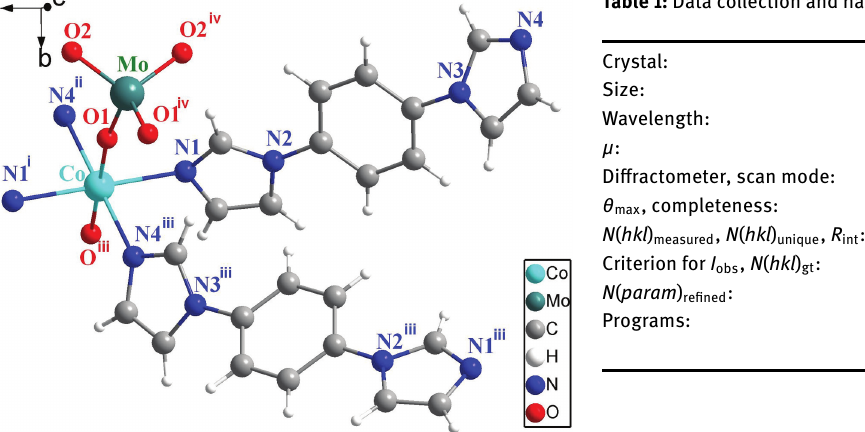
Table 1: Data collection and handling.